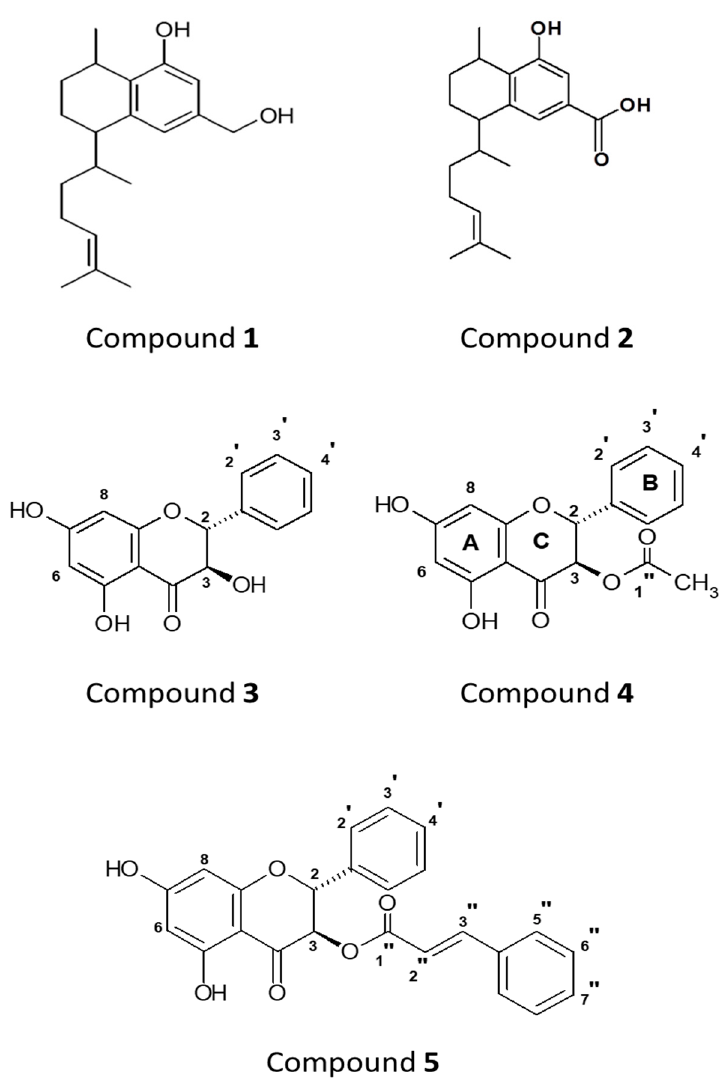
Figure 1. Chemical structures. Compound 1: 8, 19-dihydroxyserrulat-14-ene. Compound 2: 8-hydroxyserrulat-14-en-19-oic acid. Compound 3: Pinobanksin. Compound 4: Pinobanksin-3-acetate. Compound 5: Pinobanksin-3-cinnamate.